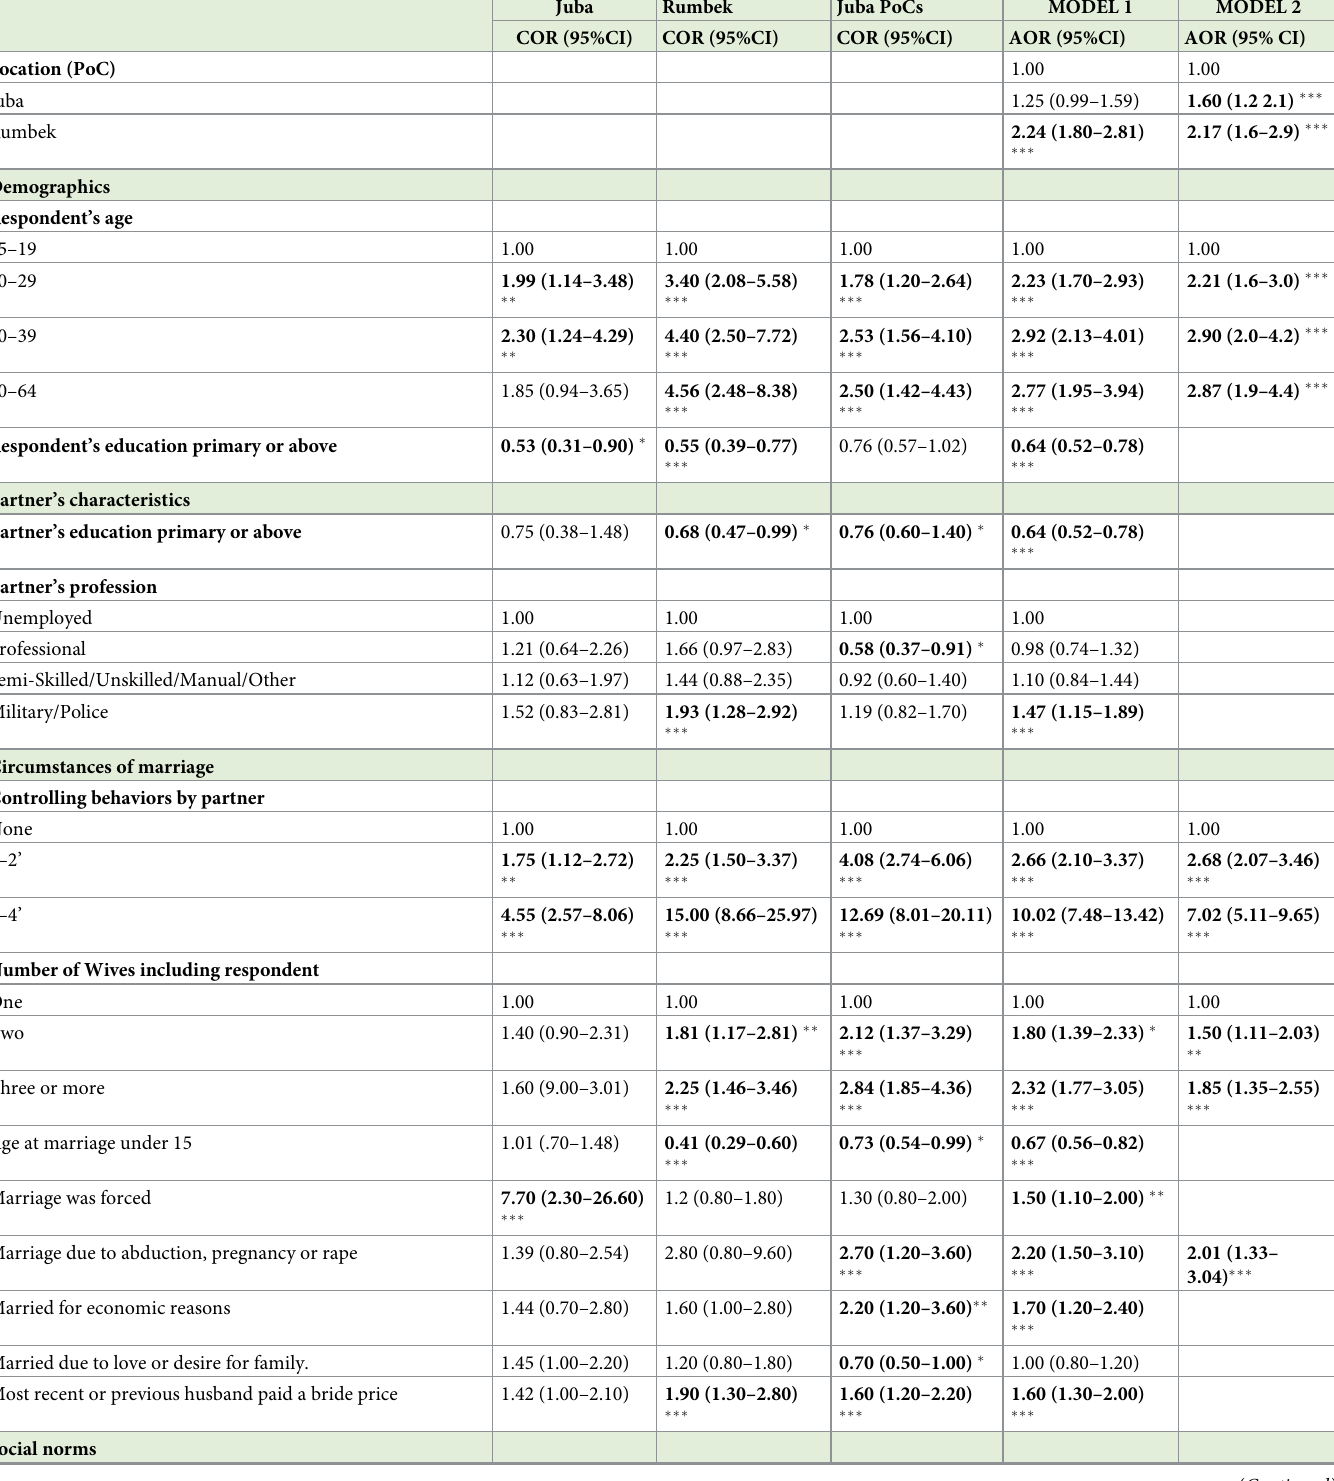
Table 8. Risk Factors for IPV a